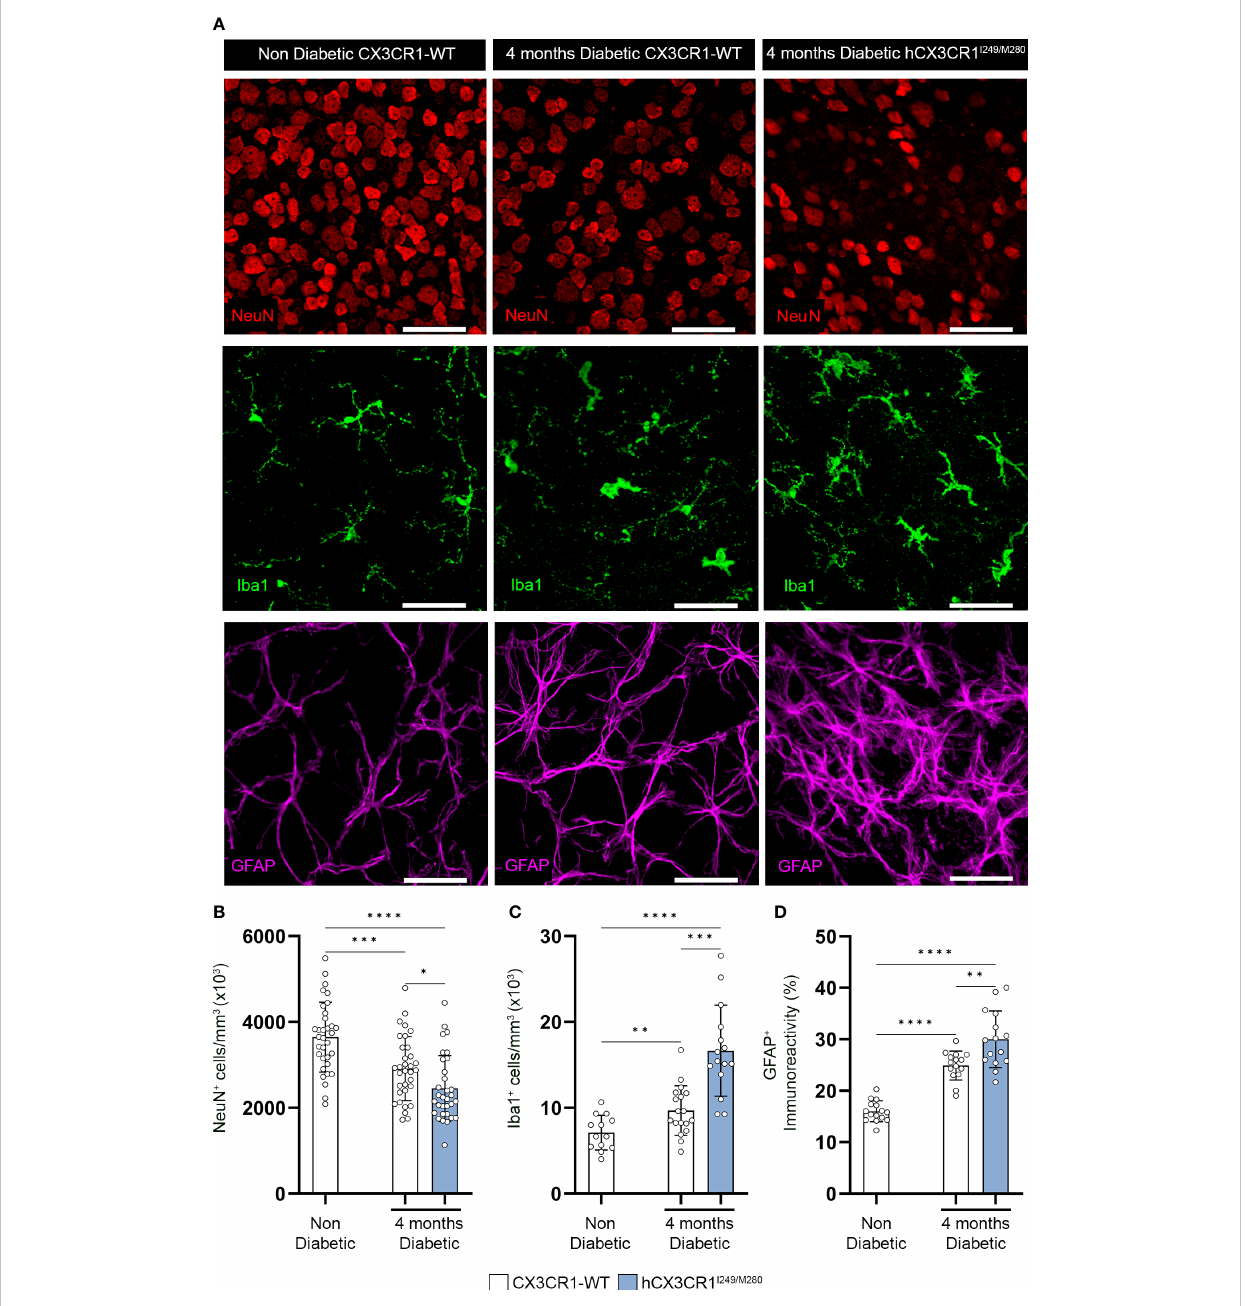
FIGURE 2 hCX3CR1 I249/M280 variant is associated with increased neuronal cell loss and reactive gliosis in the diabetic retina. Hyperglycemia was induced in CX3CR1 -WT and hCX3CR1 I249/M280 mice via i.p. injection with STZ and retinal tissues were analyzed after four months of hyperglycemia. (A) Confocal images of retinal tissues stained for Iba1 (green), NeuN (Red) and GFAP (magenta) in naïve CX3CR1 -WT and 4-months diabetic CX3CR1 -WT and hCX3CR1 I249/M280 mice. Confocal images represent the retinal ganglion cell layer in the peripheral retina. B-D, Quanti fi cation of retinal IHC analysis for NeuN + cells/mm 3 (B) , Iba1 + cells/mm 3 (C) , and percent immunoreactive area for GFAP (D) . Data show the 2 central, 2 medial and 2 peripheral images taken per mouse. Data show mean ± SD, n = 4 to 10 mice per group where each dot represents an individual mouse. * P <0.05, ** P <0.01, *** P <0.001 **** P <0.0001 using Student ’ s t -test, with Welch ’ s correction. Scale bars measure